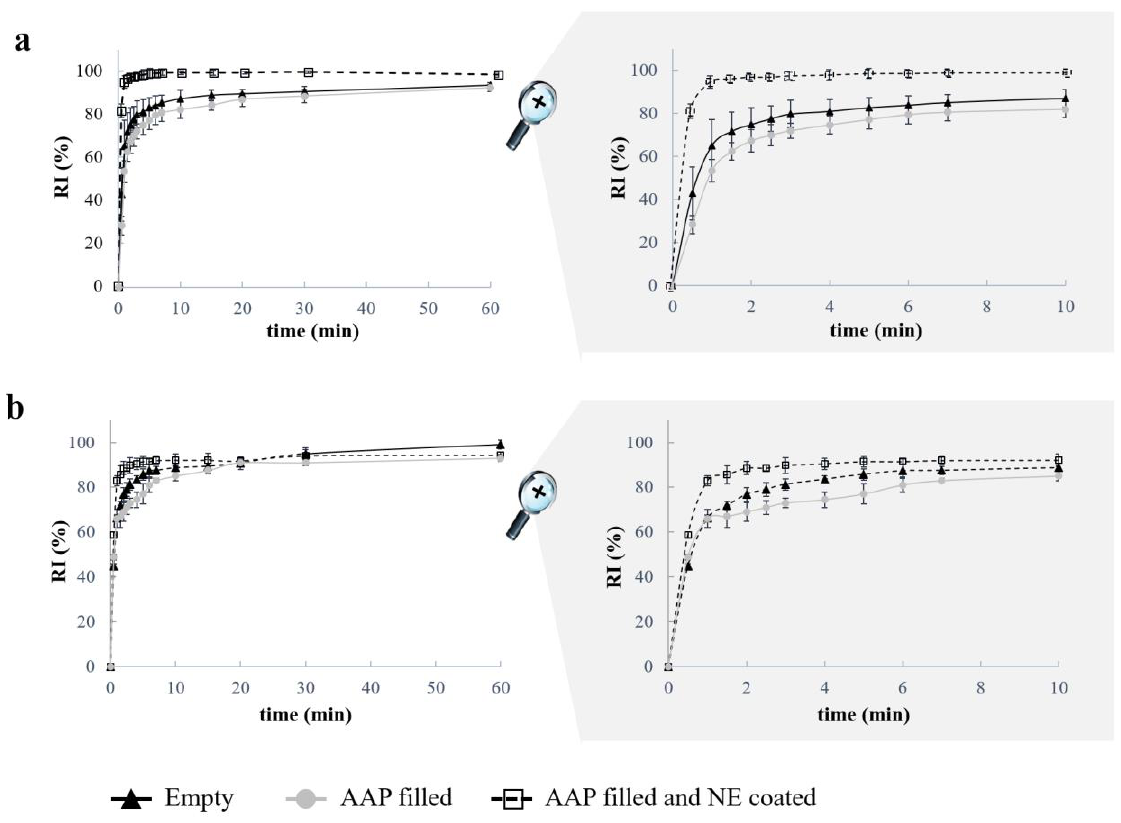
Figure 8. RI versus time curves relevant to different I-shaped samples (i.e., having empty reservoir units, being filled with the selected powder tracer and tested as such or after relevant coating) printed with ( a ) 100% and ( b ) 50% infill.